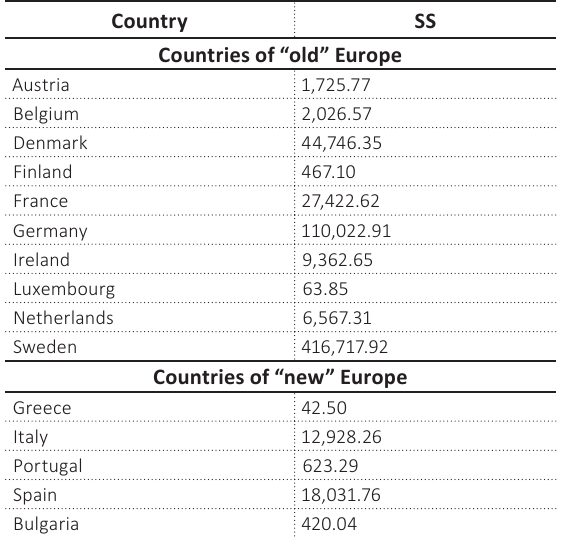
Table 3. Results of modeling innovative development in Ukraine and European